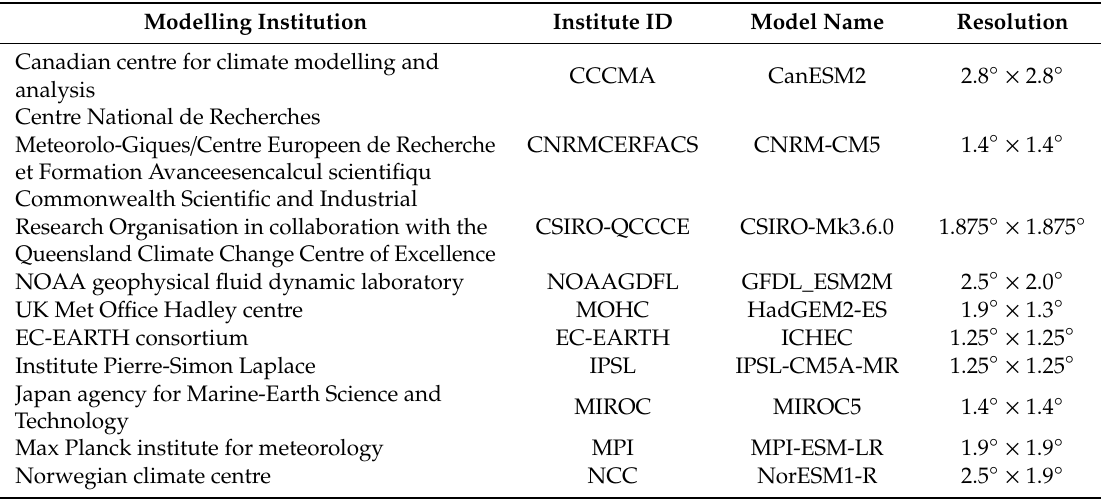
Table 1. List of dynamically downscaled Global Climate Models (GCMs) used in the